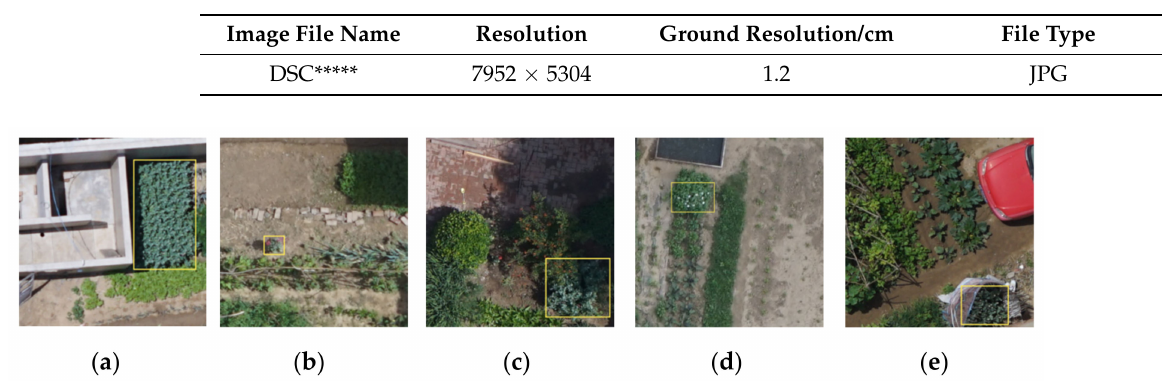
Figure 1. Low-altitude remote sensing images of villages collected by UAV. Table 2. The metadata of the image.